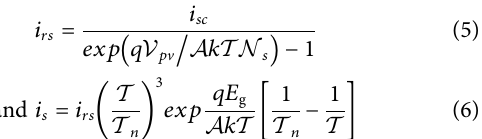
Figure 2 . The exclusive goal of modeling PV cell using a one- diode represented here is to mimic the characteristics and performance of PV cells under irregular climate conditions (Pavithra et al., 2021).